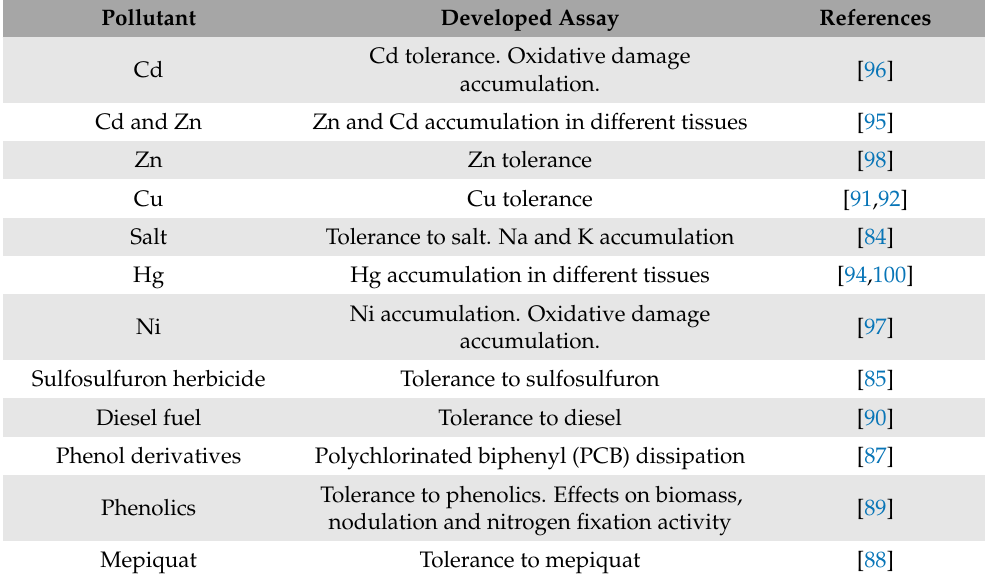
Table 1. Summary of studies of phytoremediation, tolerance, and accumulation of inorganic and organic pollutants on V. sativa